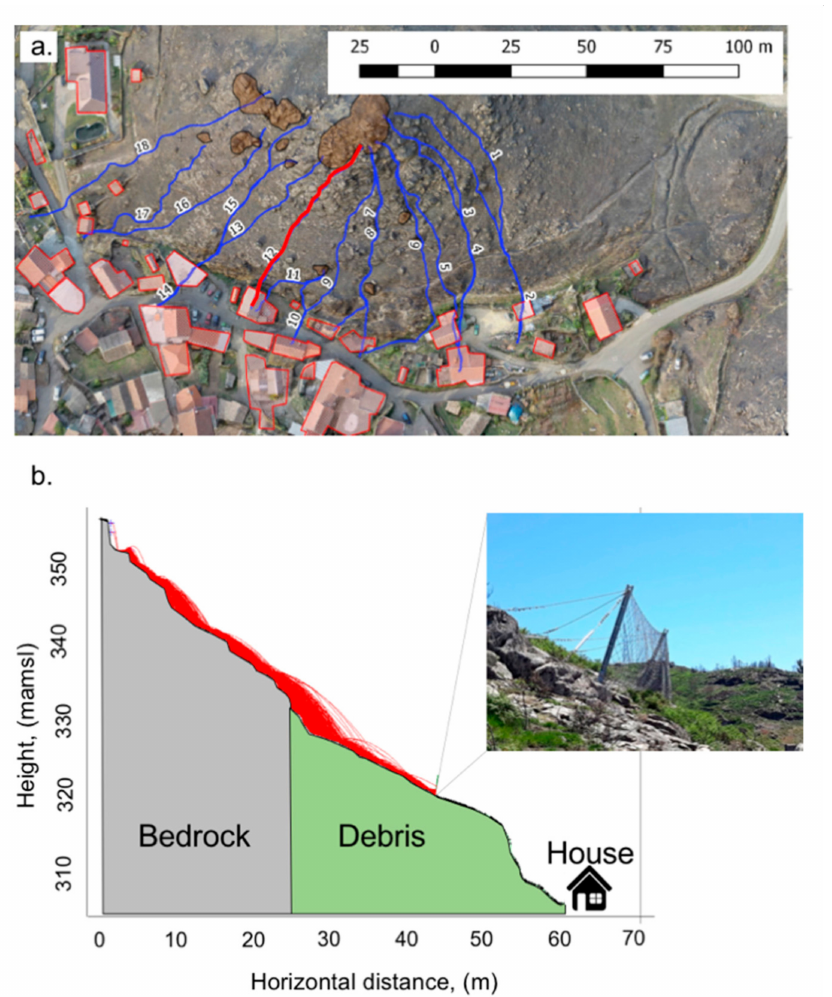
Figure 10. Modeling of rockfall paths for the study in Galicia. ( a ) Selection of maximum slope trajectories or rockfall-paths based on the 3D point cloud. Profile 12 is highlighted in red color. ( b ) Geometry of profile 12 input in RocFall code, including different materials and simulation of profile 12 with the designed flexible barrier. A picture of this barrier once installed is also